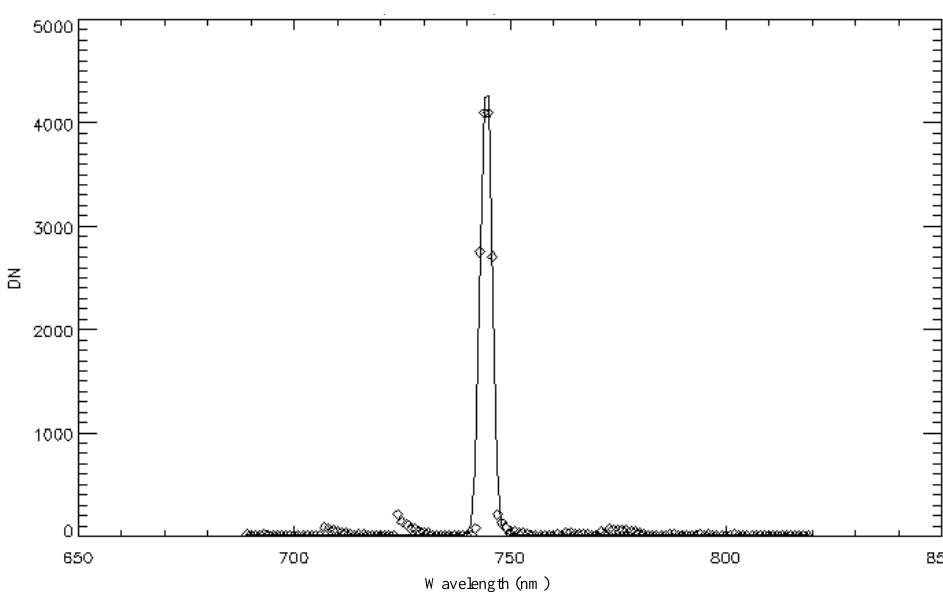
Figure 6. The spectral response (diamonds) for the 231st channel and its Gaussian fitting result (solid line): the diamonds are the actual response (DN) of the 231 st channel of the FISS system to the radiance output by the monochromator from 690 to 820 nm; the solid line is the best-fit Gaussian function from which the center wavelength and FWHM channel width can be derived.